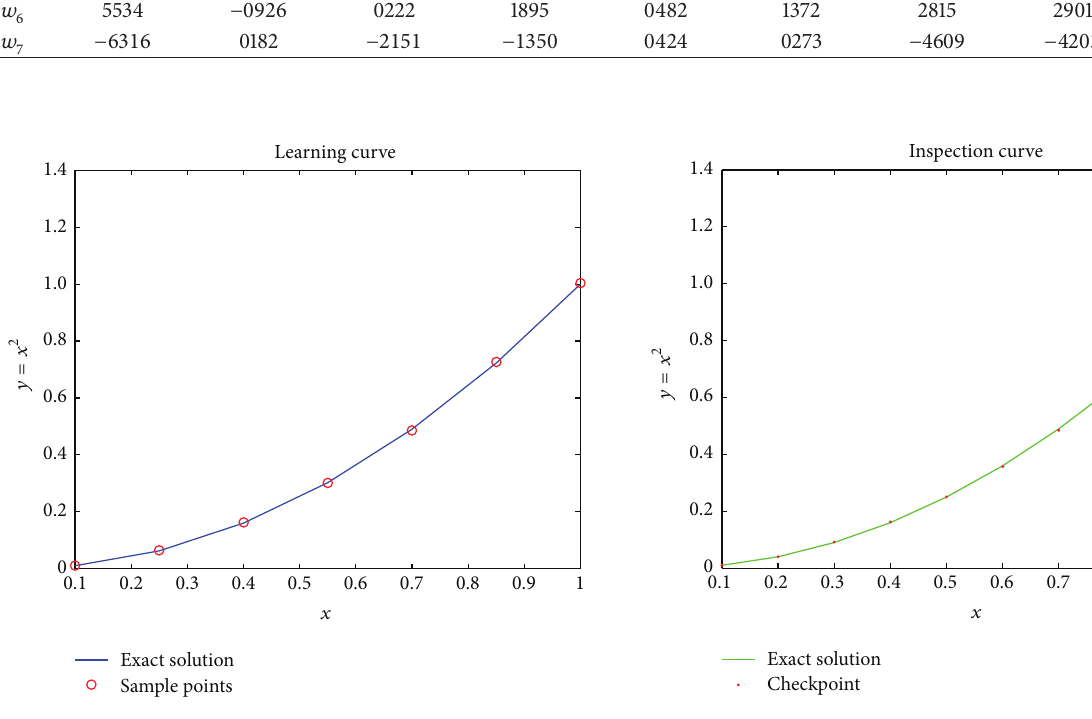
Figure 1: The learning curve for Example 1. Figure 2: The inspection curve for Example 1.